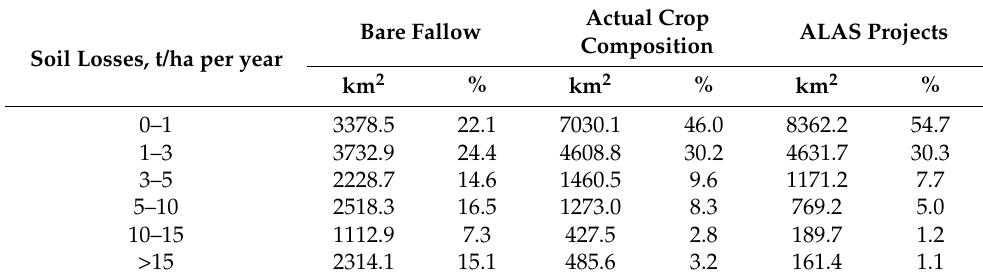
Table 2. Eroded soils areas in Belgorod Oblast, according to different land-use models.